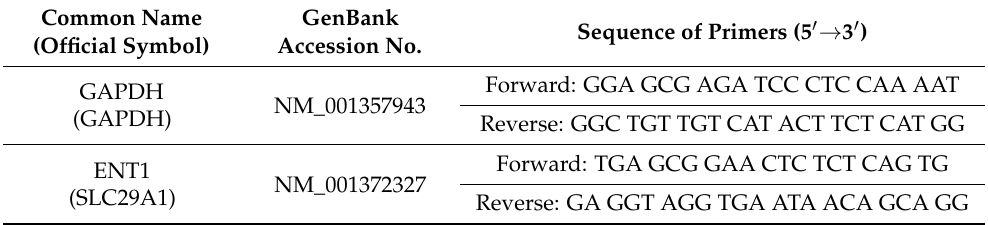
Table 1. Primer sequences for qPCR